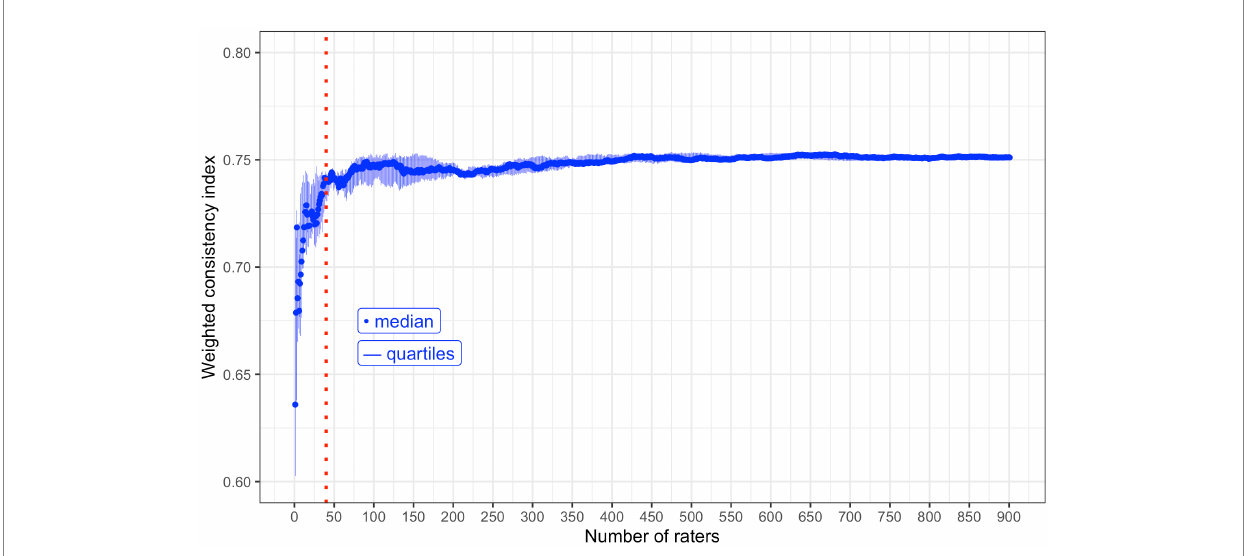
FIGURE 6 A chart to demonstrate the median weighted consistency index with increasing numbers of raters included in the calculation. This includes both student and clinical supervisor raters together. Red, dotted, vertical reference line: x = 40 raters. Forty is the minimum number of raters aimed for. This value was calculated using data taken from raters of a single demographic group (Supplementary material